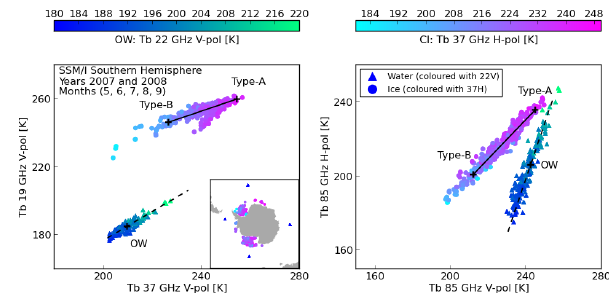
Figure 2. Same as Fig. 1, but in the Southern